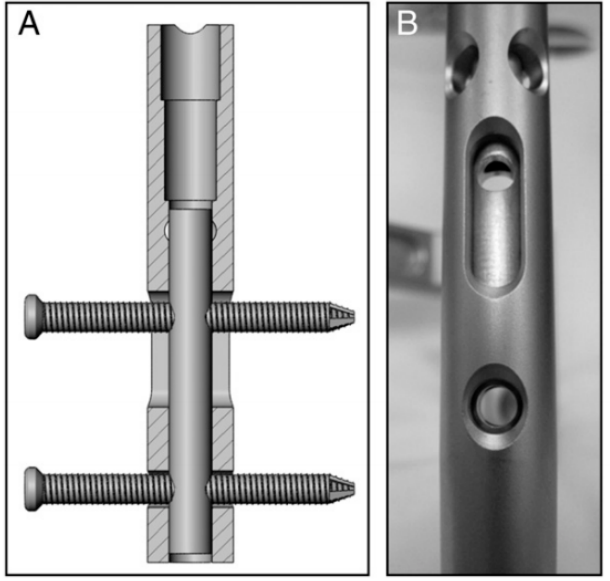
Figure 4. ( A , B ) Prior to implantation of the nails, a micromotion insert was placed in the proximal cannulus of each nail. An insert in the proximal nail stem was used to align two 3.9-mm locking bolts—one in the dynamic slot and one in the 5-mm static locking hole. This configuration produced 1.1 mm of free axial travel (according to [54]).